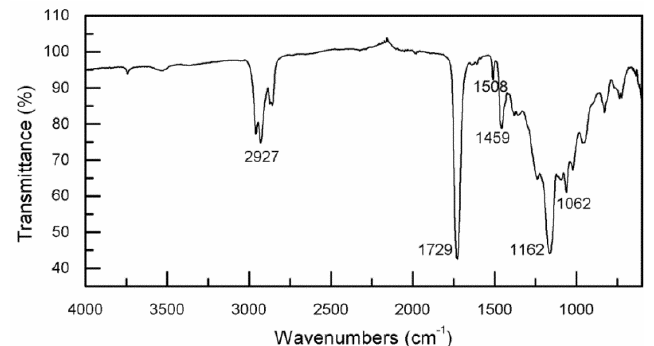
Figure 2. Infrared spectrum of AESO-DBI (1:1)